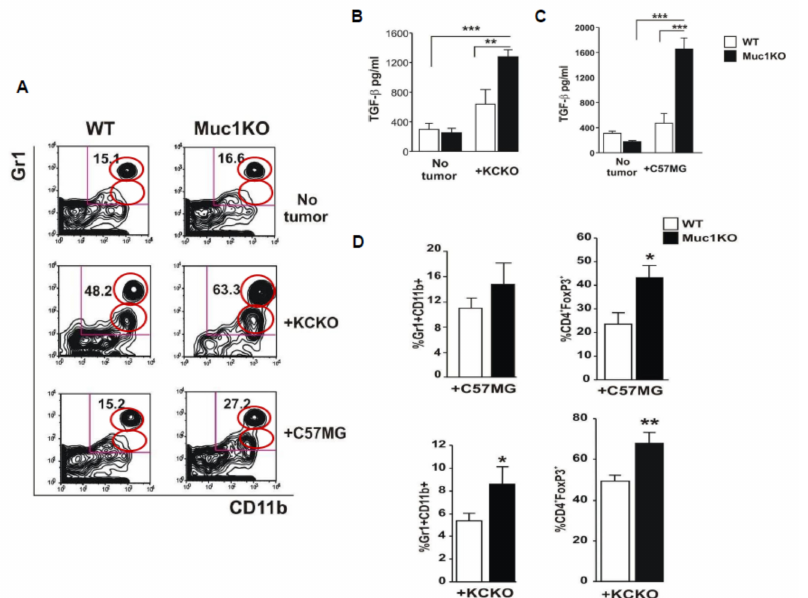
Figure 2. Cancer bearing MUC1KO mice have higher frequency of MDSCs creating a more immune suppressive environment. ( A ) Splenocytes from healthy and tumor bearing WT and Muc1KO mice were isolated and labeled with anti Gr1-APC and CD11b-PECy7 antibodies. Representative contour plots of Gr1 + CD11b + cells from three separate experiments are shown; the MDSC subsets were obtained by gating on high SSC and high FSC cells using an isotype control antibody and further on high Gr1 + and low Gr1 + CD11b + cells. The red circles represent the percent depicted on the right top quadrant for each of the groups. ( B , C ) Levels of TGF- β was measured in the serum of healthy and cancer bearing WT and MUC1KO mice using ELISA kits. ( D ) Levels of MDSCs and CD4 + FoxP3 + cells were measured in the tumor of WT and MUC1KO mice using flow cytometry. High SSC and FSC was gated for the lymphocyte population, then CD4 + T cells were gated on the lymphocyte population, and the CD25 + FoxP3 + double positive cells were gated on the CD4 + T cell